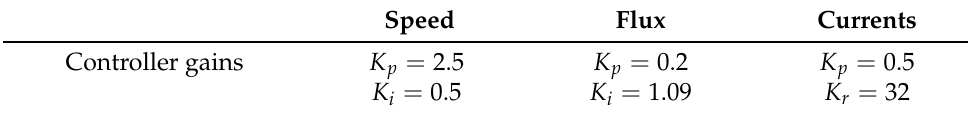
Table 2. Controller